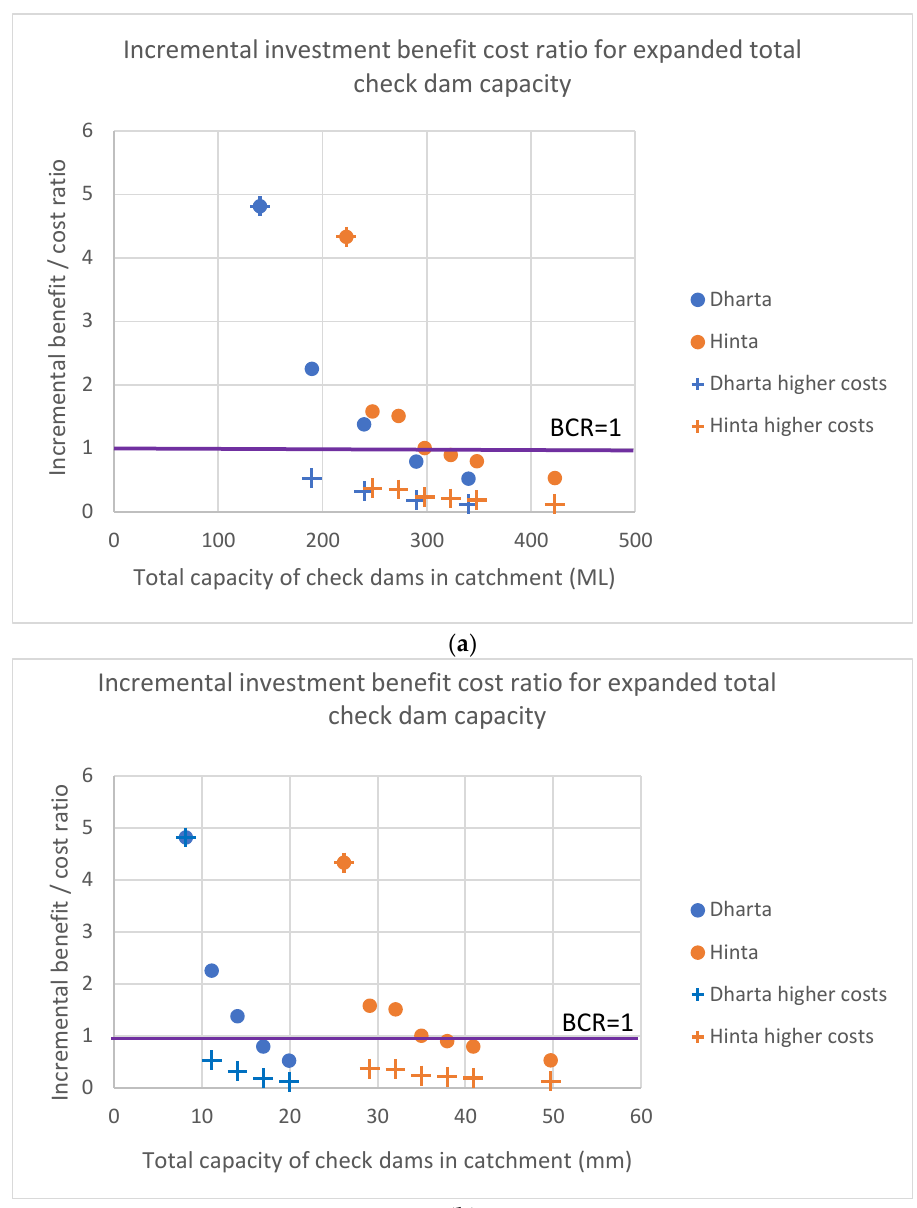
Figure 10. Expected benefit – cost ratio of incremental investments in check dams in the Dharta and Hinta catchments for a range of aggregate capacity, expressed as ( a ) megalitres and ( b ) millimetres over the whole catchment area. Graphs show cases where upstream check-dam costs have the same discounted costs as downstream check dams and also when the unit capacity costs are higher by a factor of 4.26, matching the discounted actual costs reported for these catchments.